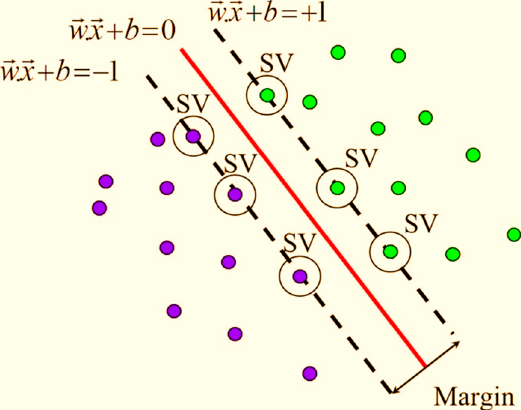
Figure 3. The diagrammatic representation of SVM for separation hyper-plane in 2D [22].